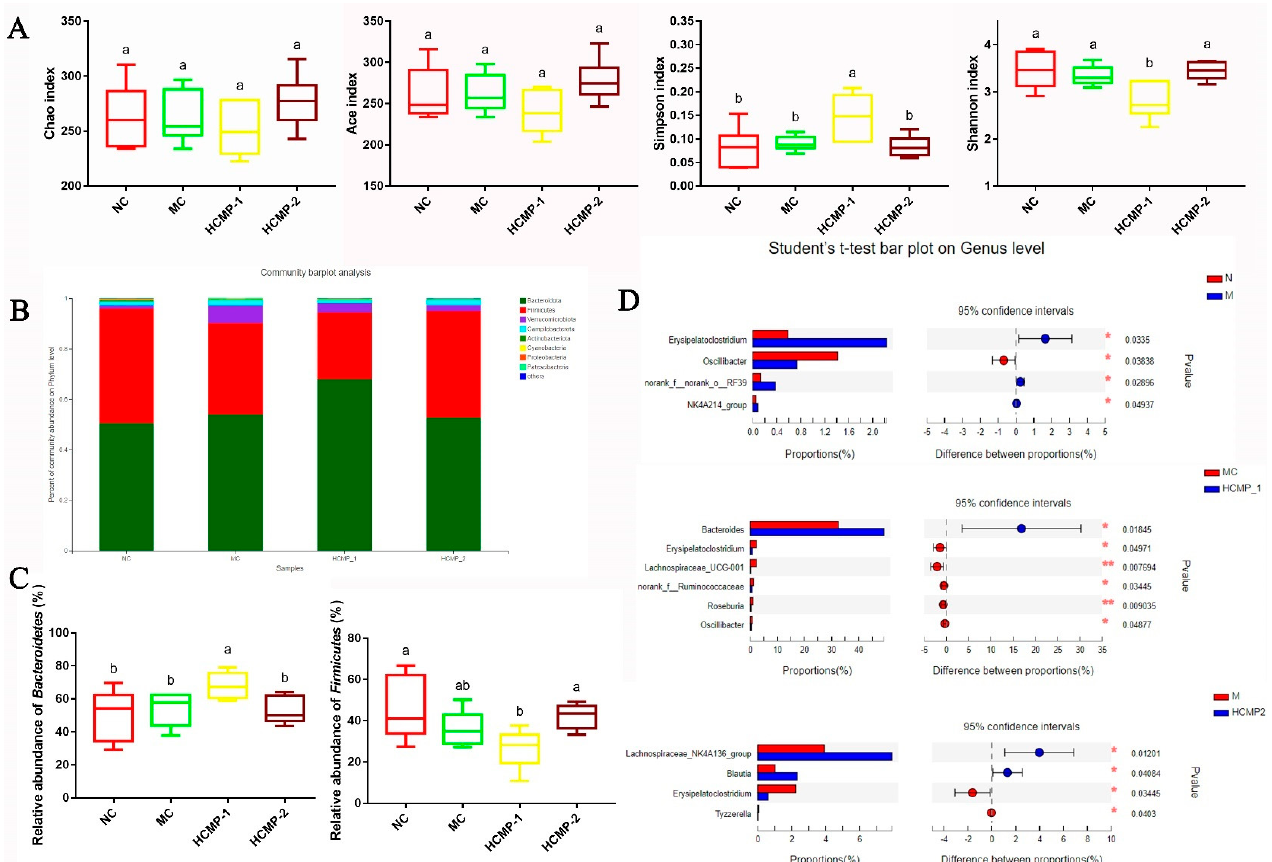
Figure 7. Effects of CMP-1 and CMP-2 administration on gut microbiota. ( A ) Alpha diversity evaluated from Chao, ACE, Shannon and Simpson indexes; ( B ) bacterial taxonomic profiling at the phylum level of the gut microbiota; ( C ) the relative abundances of Bacteroidetes and Firmicutes. One-way ANOVA procedure followed by the Dancan test was used to evaluate the statistical significance. The significant differences ( p < 0.05) are marked as various superscript small letters. ( D ) Differentially the abundant of gut microbiota between the NC and MC, MC and HCMP-1, MC and HCMP-2 groups Wilcoxon rank sum test.